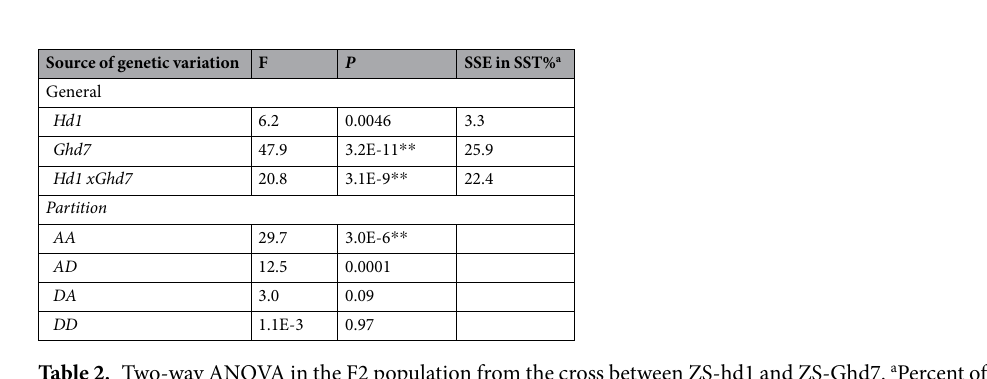
from MH63 and crossing MH-Hd1 with MH-ghd7 possessing a non-functional ghd7 from ZS97. In NLD, Ghd7 significantly interacted with Hd1 in determining the heading date in ZS97 background (Table 2). Under LD, Hd1 promoted heading date by 14.7 and 5.6 days without Ghd7 in ZS97 and MH63 backgrounds, respectively, and Hd1 correspondingly repressed heading date by 8.3 and 12.3 days in the presence of Ghd7 (Fig. 4A,B). Accordingly, the effect of Ghd7 on delaying heading date was significantly altered between the Hd1 and hd1 backgrounds. Ghd7 in the ZS97 background with Hd1 delayed heading by 29.3 days, but the delay was decreased to 6.3 days without Hd1 , while Ghd7 in MH63 background with Hd1 delayed heading by 14.8 days, but promoted heading by 2–3 days without Hd1 (Fig. 4A,B). In SD, regardless of the presence or absence of Ghd7 , Hd1 consistently promoted the heading date by 14.1 and 19 days in the ZS97 background and by 11.6 and 7.4 days in the MH63 background